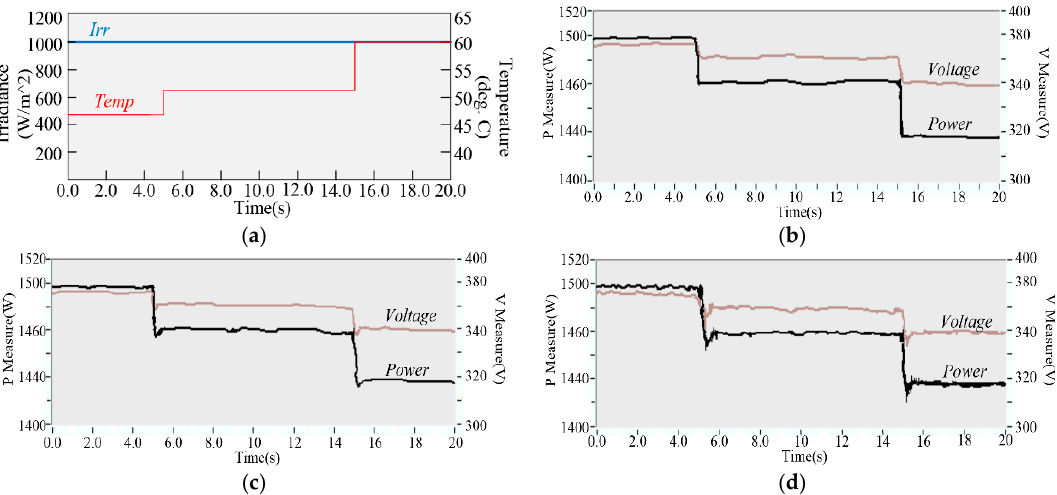
Figure 16. Under temperature step change: ( a ) Experimental results of MPPT control; using ( b ) VUFLC, ( c ) FLC and ( d ) INC.